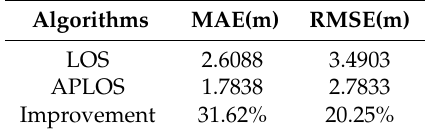
Table 8. Performance metric of lawnmower path following ( u = 1.5